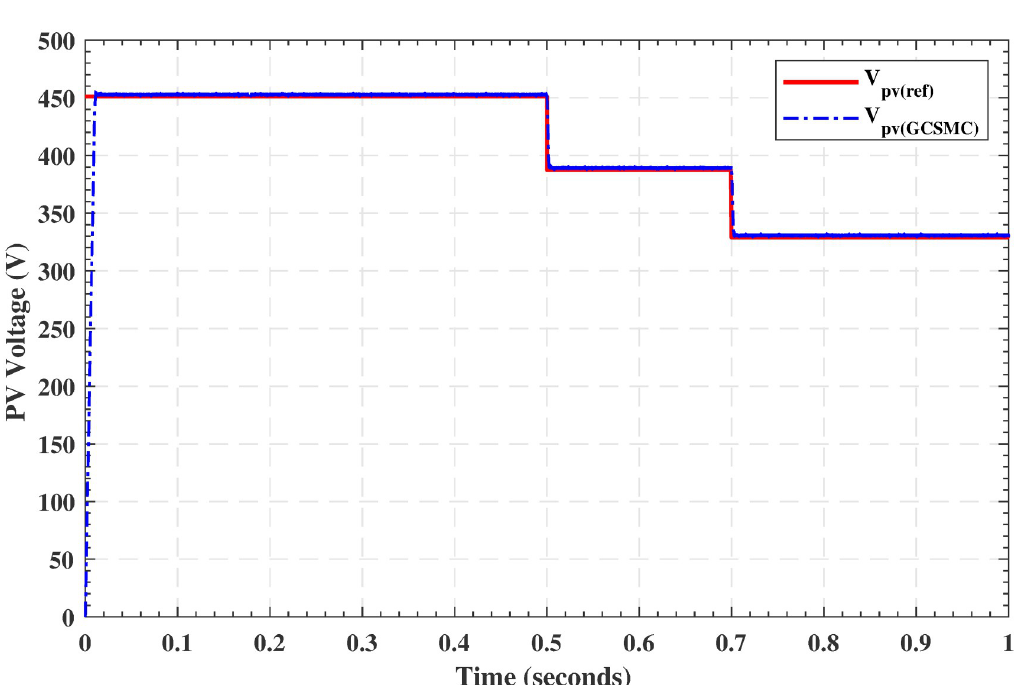
Fig 17. Tracking of V pv with respect to V ref under simultaneous variation in temperature and irradiance.